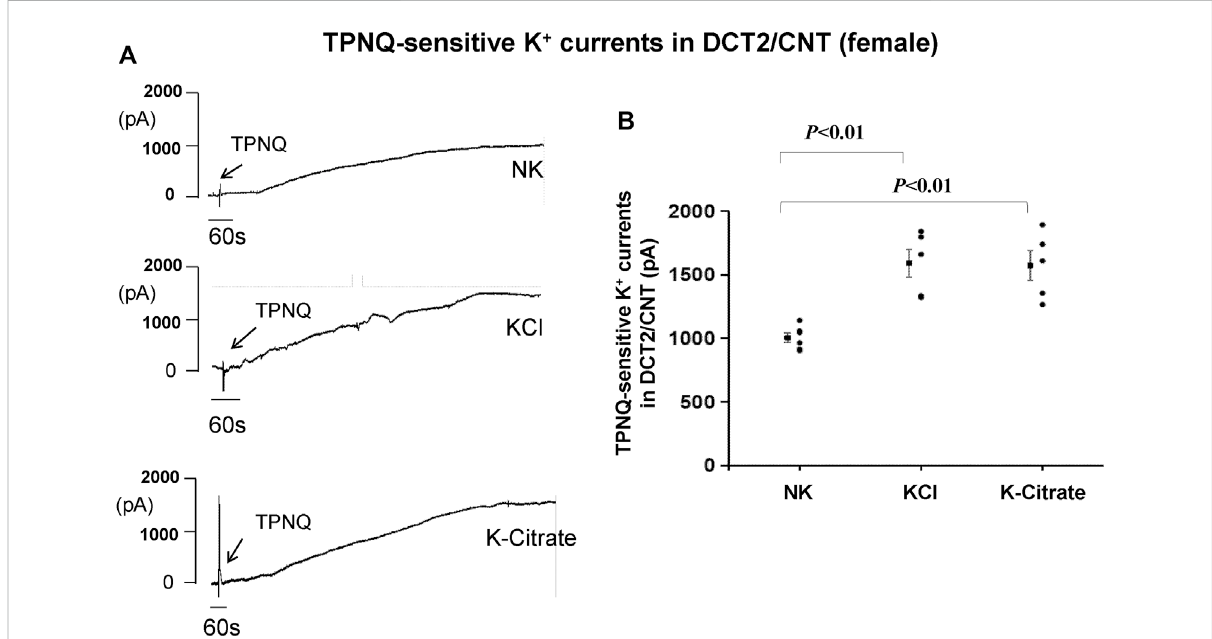
FIGURE 8 HKintakestimulatesROMKintheDCT2/CNToffemalemiceregardlessCl − content. (A) Asetofwhole-cell recordingsshowsTPNQ(400 nM)- sensitive (ROMK-mediated) K + currents in the DCT2/CNT of the female mice on NK, 5% K-Cl, and 5% K-citrate diet for 7 days, respectively. The K + currents were measured with gap-free protocol at − 40 mV using symmetrical 140 mM KCl solution in the bath and pipette. (B) A scatter graph summarizes the values measured at – 40 mV in the DCT2/CNT of female mice on different K + diets. The mean value and SEM are shown on the left of each